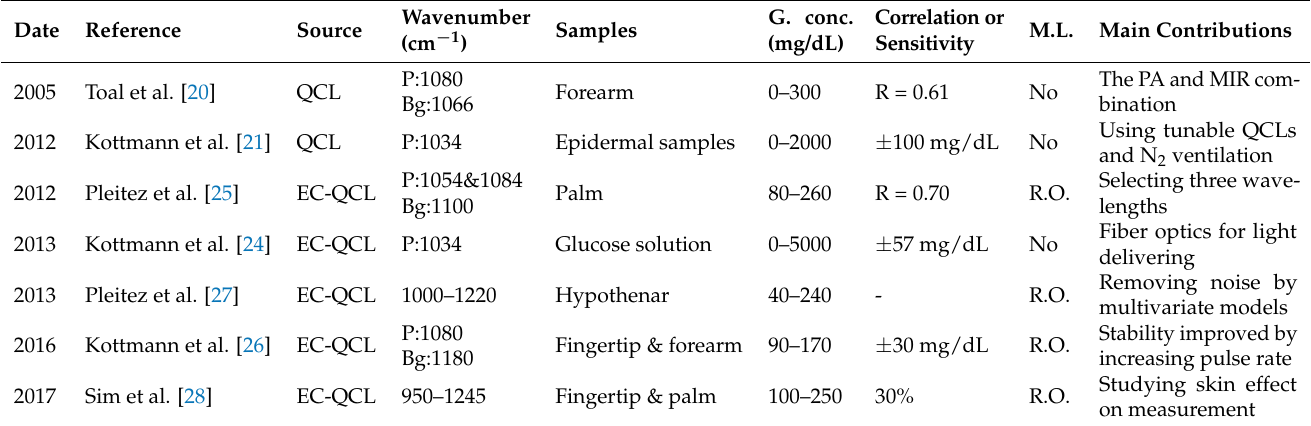
Table 3. Recent progress in PA and MIR combined spectroscopy for glucose